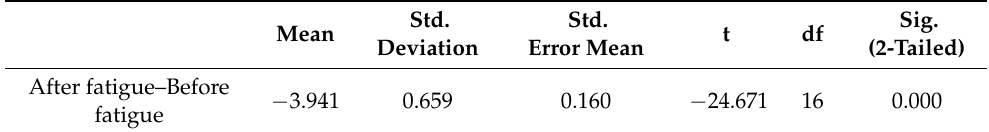
Table 3. Paired samples t -test result.